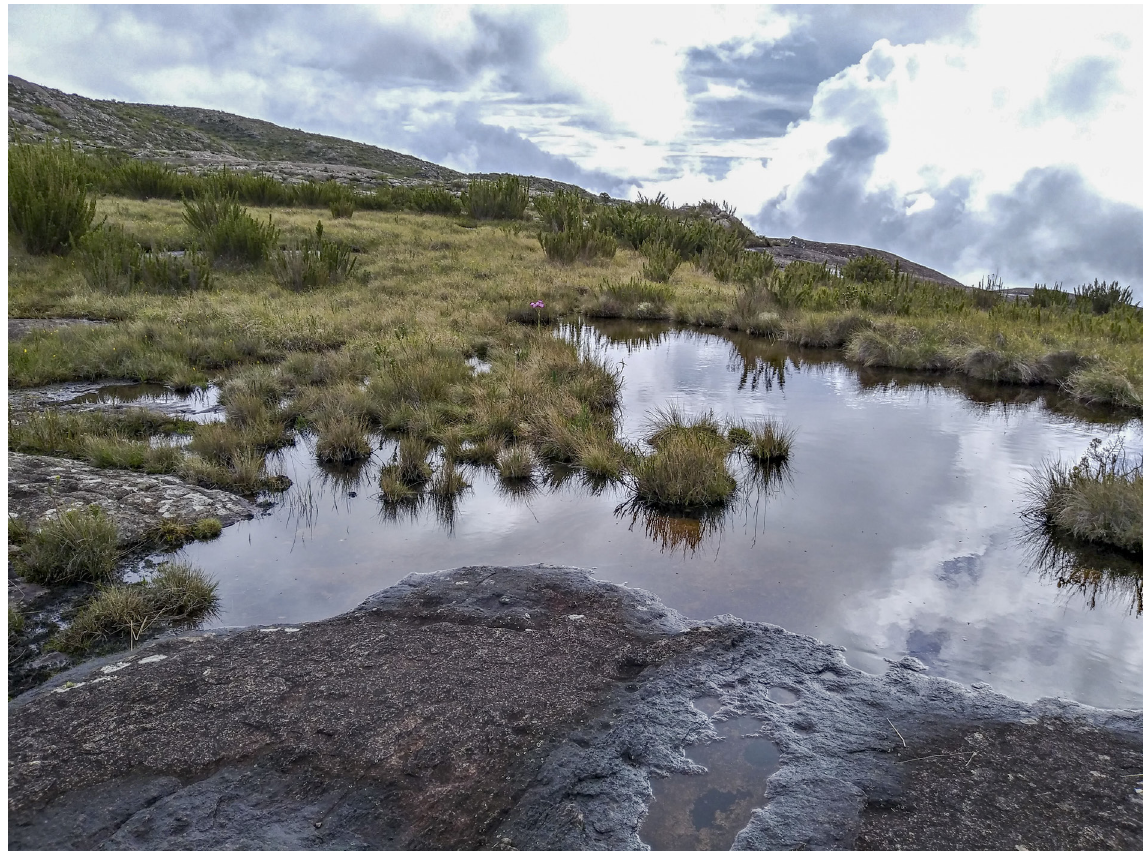
Fig. 9. Type locality of Physalaemus araxa sp. nov., Lagoa da Sombra, at Parque Nacional do